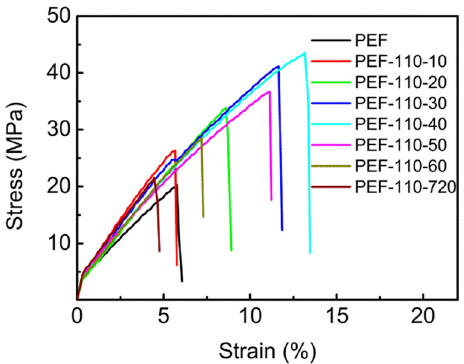
Figure 6: Tensile stress – strain curves of PEF - 110 - t .